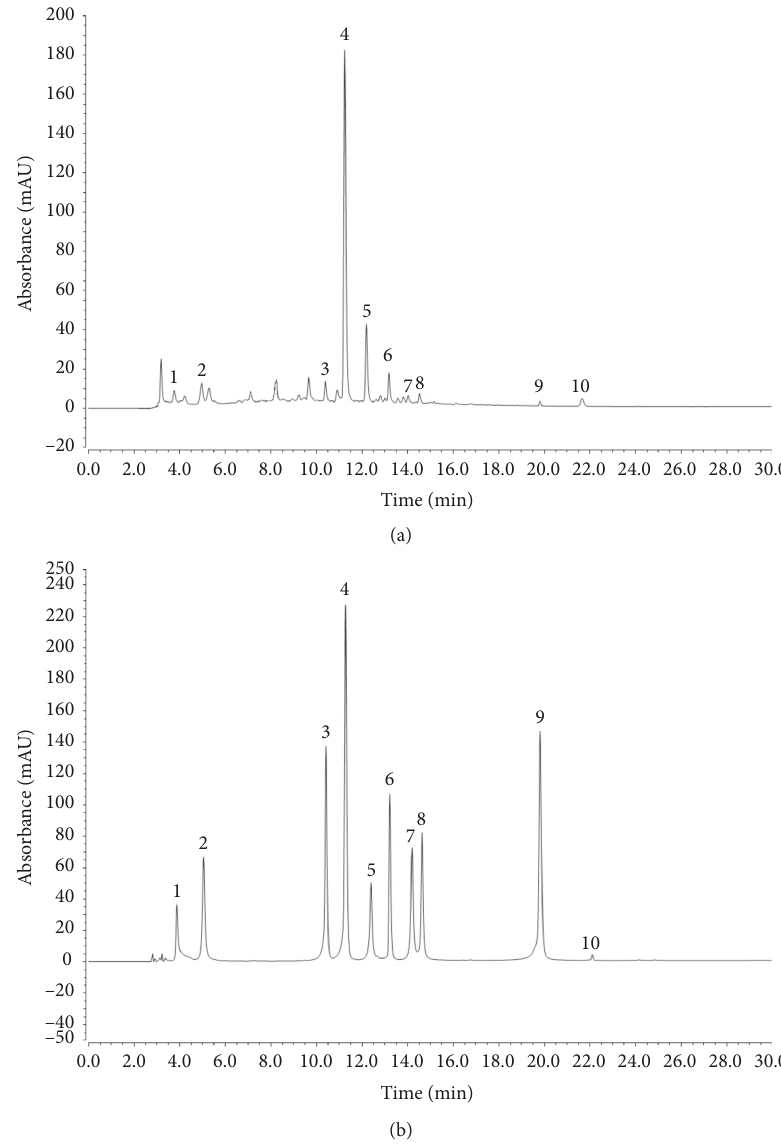
Figure 1: Analysis of the constituents of AVTE via HPLC assay. (a) AVTE chromatogram and (b) standard